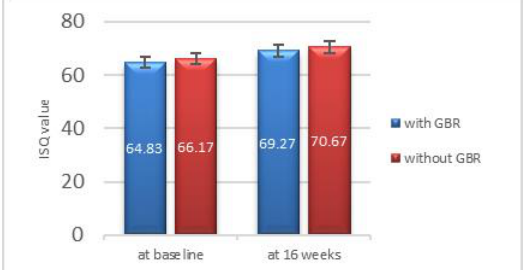
Figure 11: Comparison of ISQ value between cases with GBR and cases without